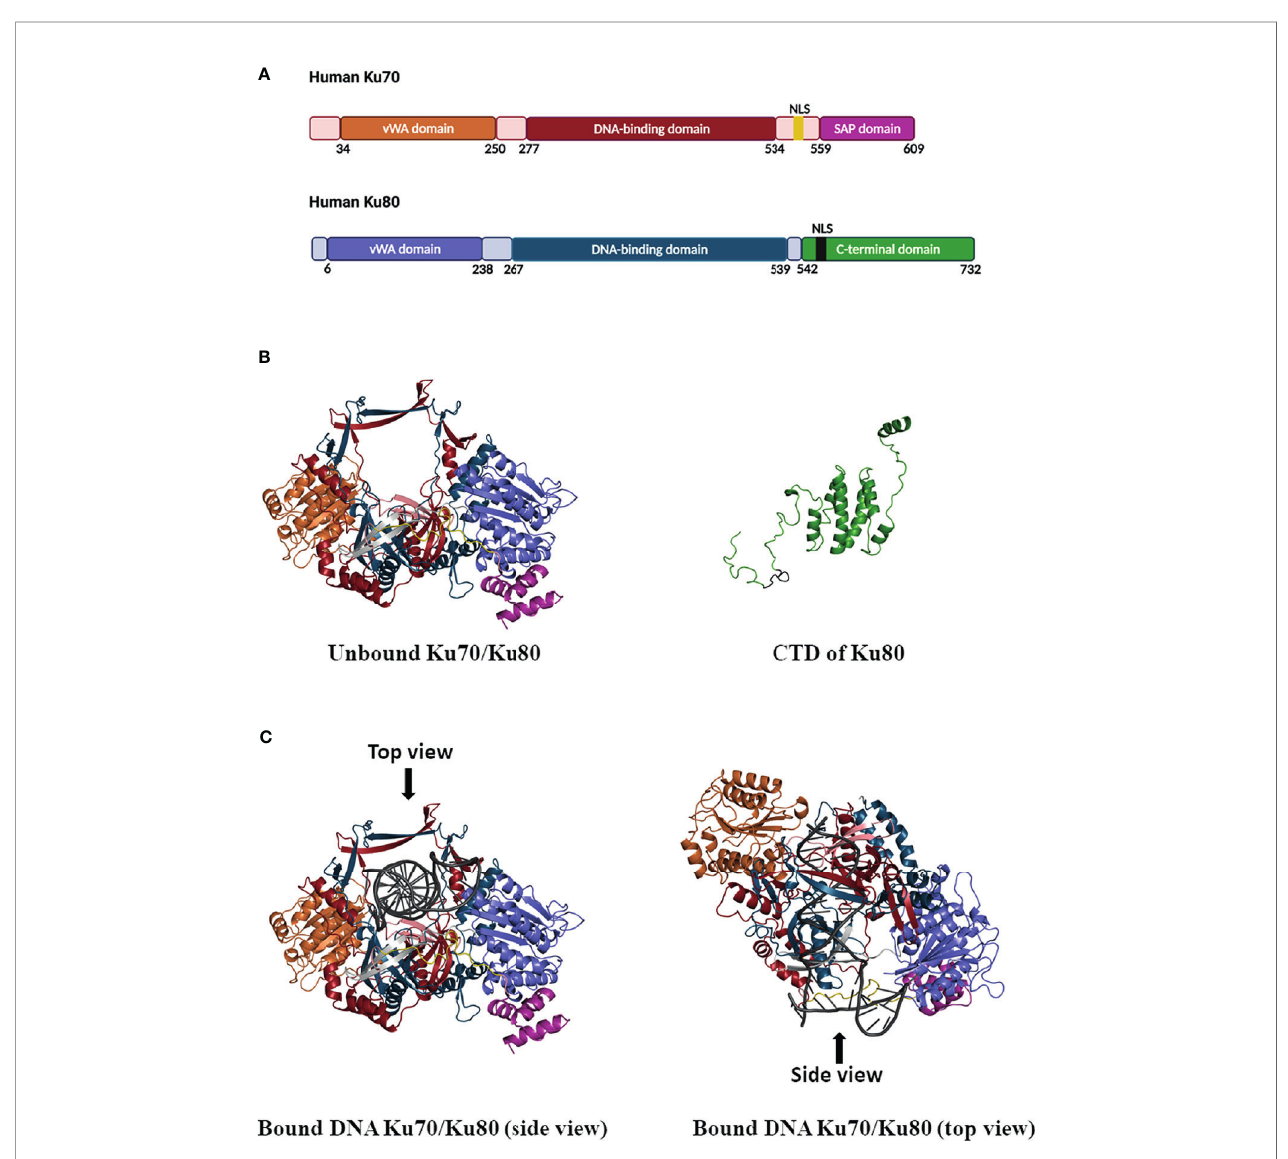
FIGURE 1 | Schematic of Ku70/80 heterodimer domains and ribbon diagrams. (A) Domains in Ku70 and Ku80. In Ku70, the vWA domain is colored in orange, the DNA-binding domain is colored in fi rebrick, the SAP domain is colored in pink, the nuclear localization sequence (NLS: 539 – 556) is colored in yellow, and other parts are colored in light pink. In Ku80, the vWA domain is colored in purple, the DNA-binding domain is colored in blue, the c-terminal domain of Ku80 is colored in green, the NLS (561-569) of Ku80 is colored in black, and other parts are colored in light grey. (B) Unbound Ku70/Ku80 heterodimer with a view of Ku70 NLS (yellow) in the front (left panel). The range in the Ku70 model is from 35 – 609 amino acids, where the fi rst 34 residues in the N-terminal domain (NTD) are truncated. The range in the Ku80 model is from 6 – 541 amino acids, where the fi rst 5 residues in the NTD and residues 542 – 732 in the C-terminal domain (CTD) are truncated. The CTD domain of Ku80 is colored in green, and the corresponding NLS (561 – 569) is colored in black (right panel). (C) The structure model of the Ku70/Ku80 heterodimer bound with DNA. The left and the right panel demonstrate the side and top view, respectively, and bound DNA is colored in dark